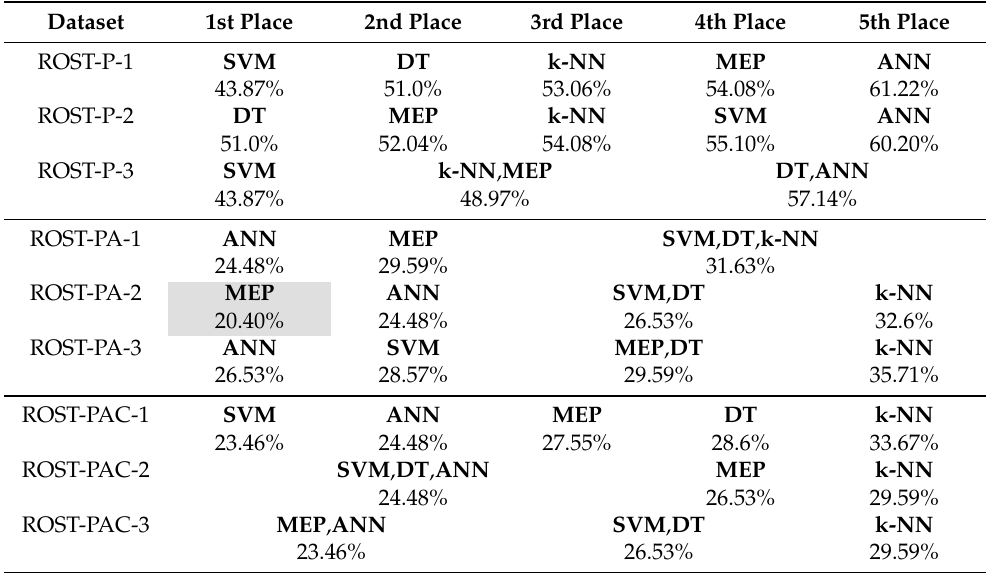
Table 16. Top of methods on each shuffle of each dataset, based on the best results achieved by each method. The gray-colored box represents the overall best (i.e., for all datasets and with all methods). Dataset 1st Place 2nd